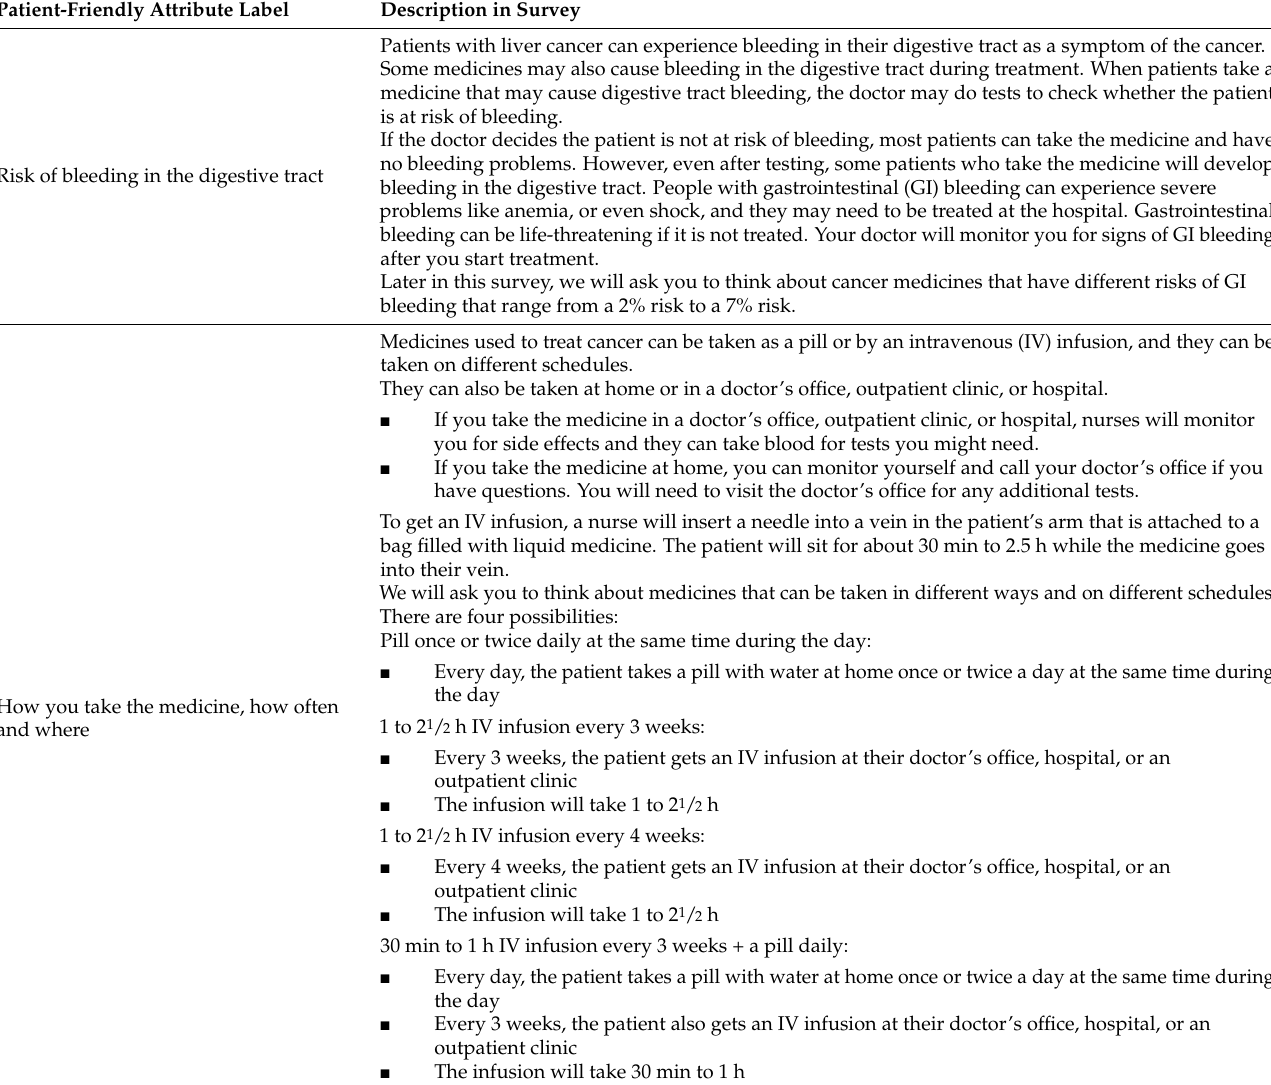
Table A1. Cont. Patient-Friendly Attribute Label Description in